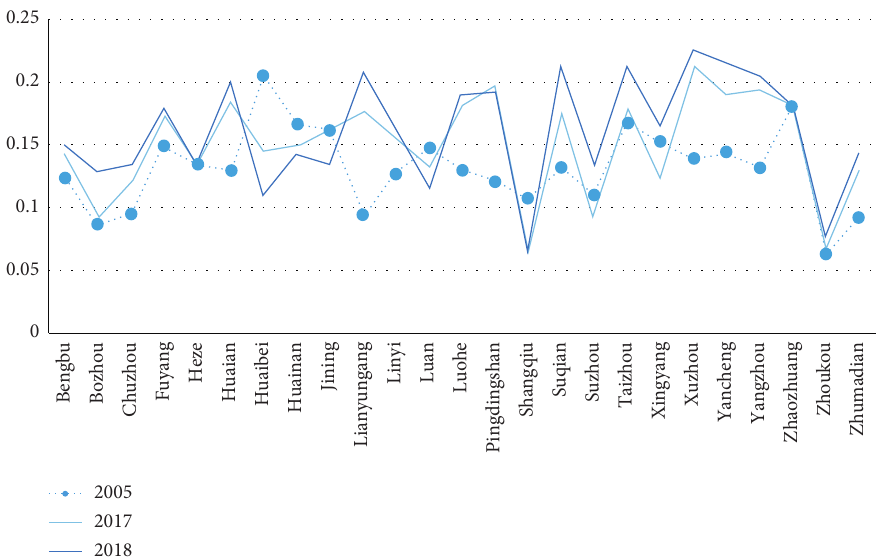
Figure 6: Comparison of people’s living competitiveness in different